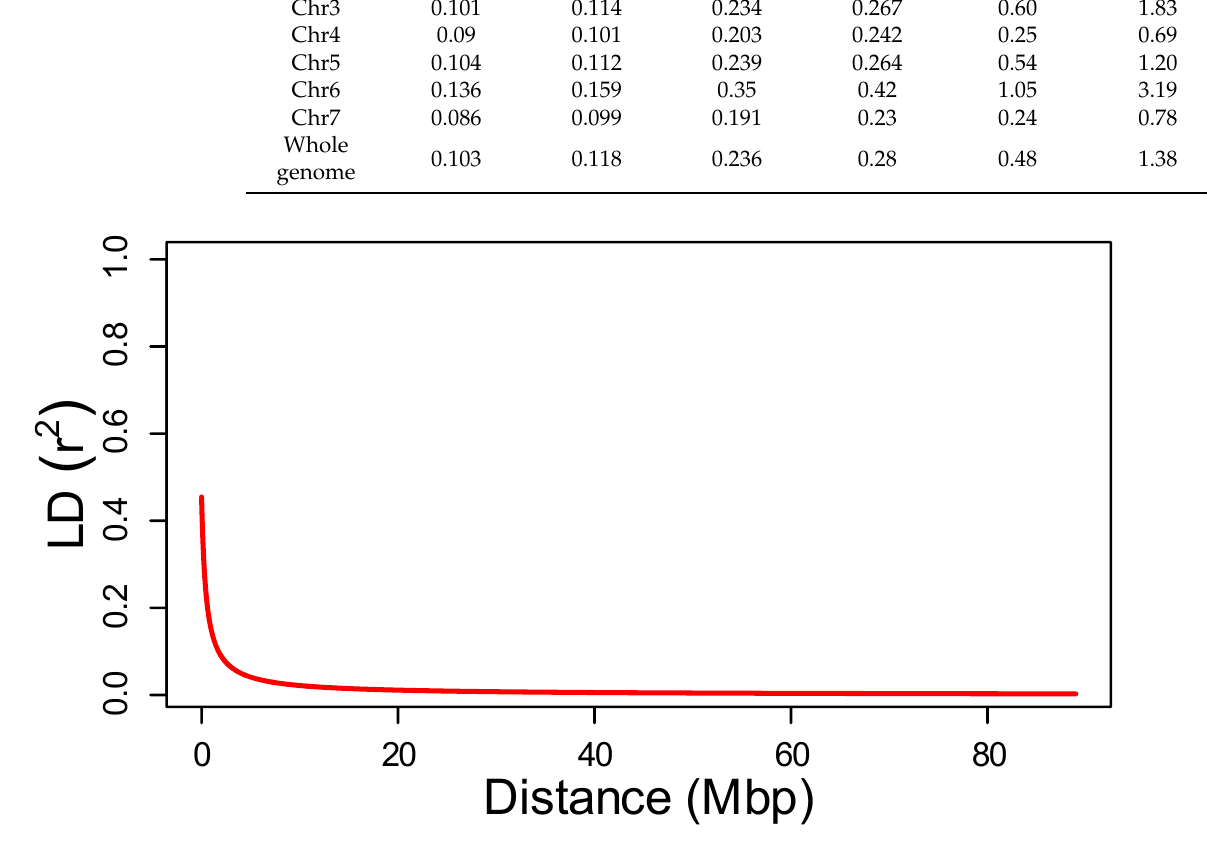
Figure 2. Estimation of the average distance of LD decay. LD decay plot showing pairwise LD values (r 2 ) on the x -axes plotted against genetic distance Mbp on the y -axes. The fitted red line is a nonlinear log curve of r 2 on genetic distance.